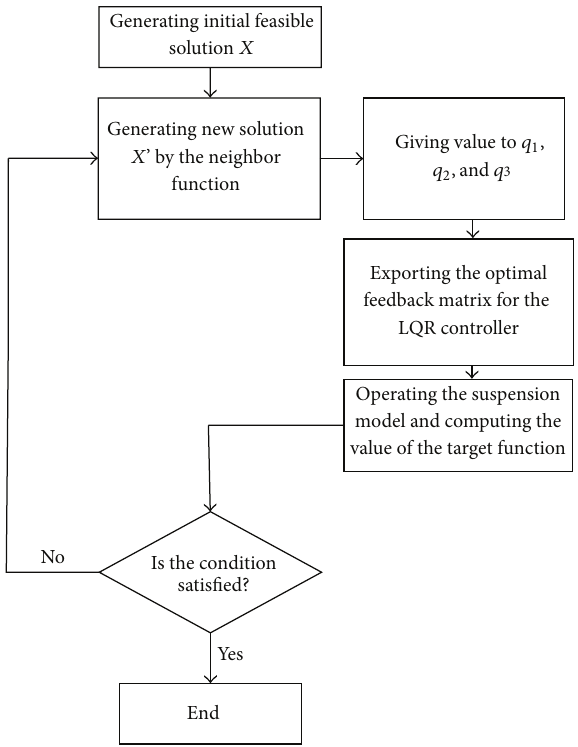
Figure 2: The optimization process for the LQR controller by the